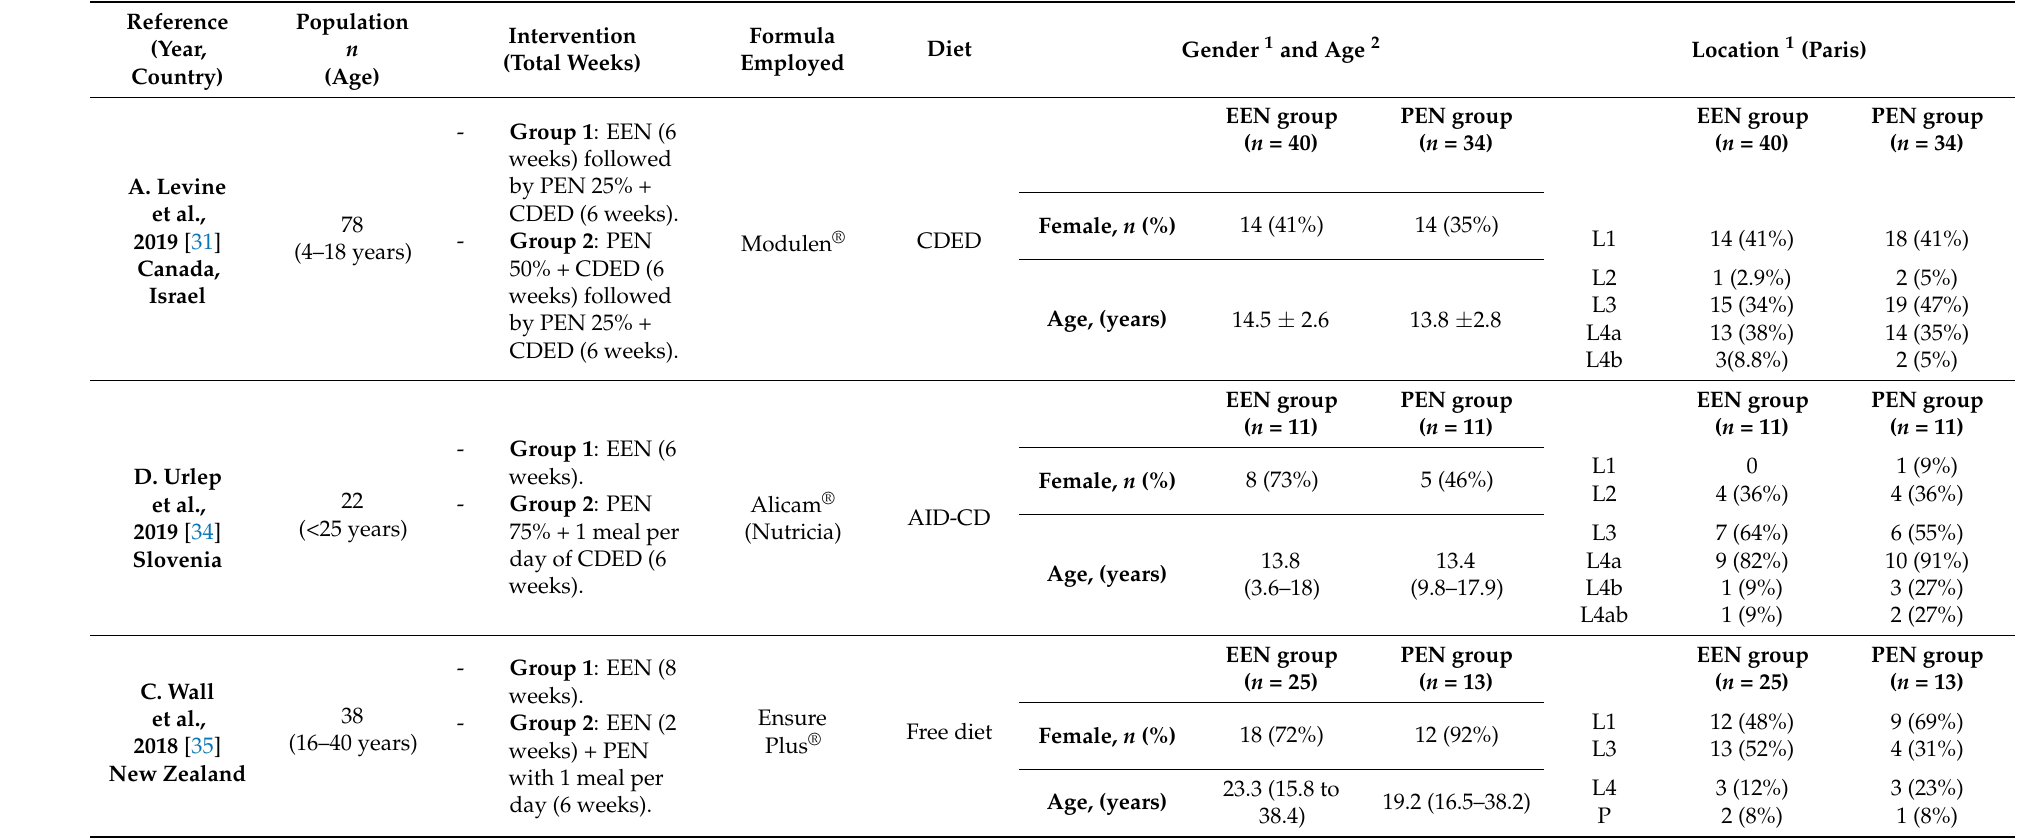
Table 3. Characteristics of the included